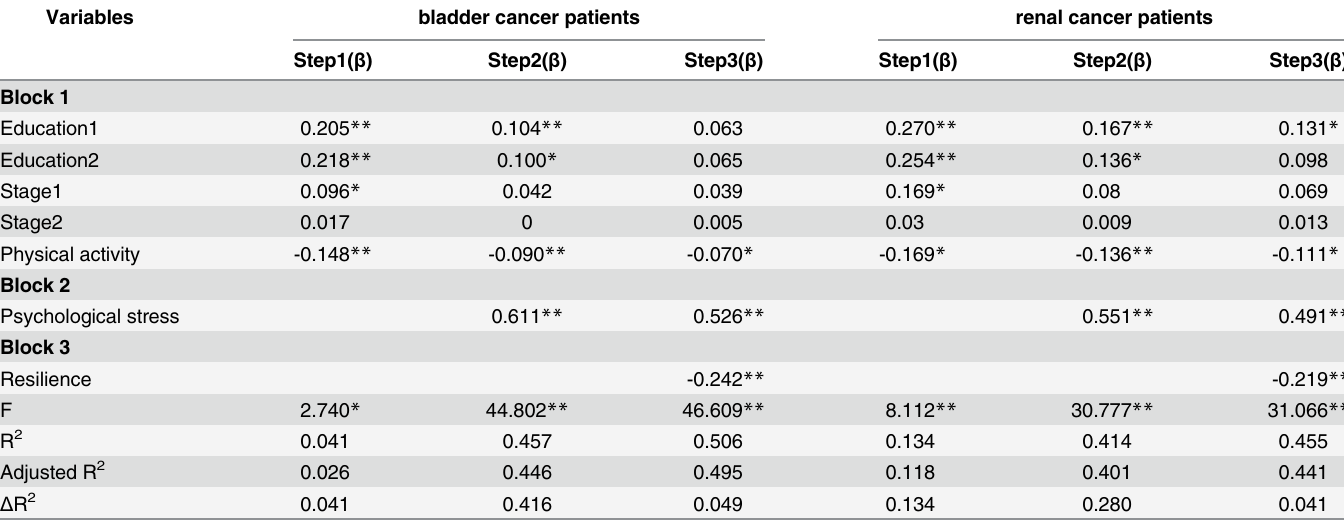
Table 4. Hierarchical linear regression analyses results of anxiety